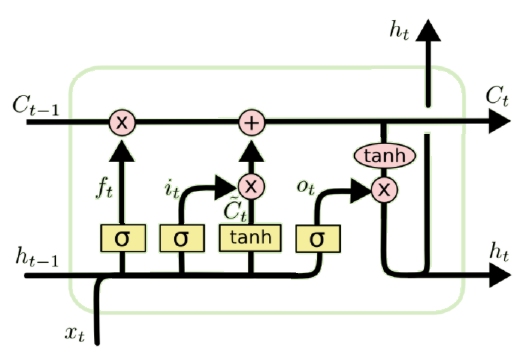
Figure 1. Architecture of LSTM Neural